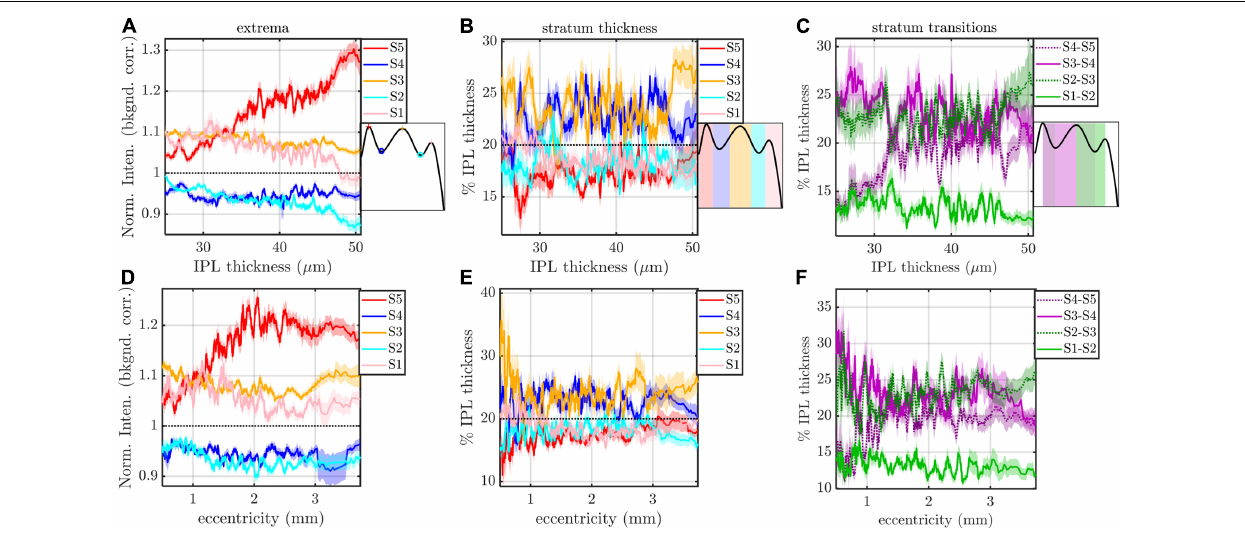
FIGURE 7 | Rolling average (mean ± std. err., window size of 21) of IPL stratification parameters (extrema, thicknesses, and transitions) versus IPL thickness (A–C) and eccentricity (D–F) . The most salient feature is an increase in the intensity of S5 with IPL thickness (A) and an increase and pleateau in the intensity of S5 with eccentricity (D) . S3 and S4 are consistently thicker, regardless of IPL thickness (B) and eccentricity (E) . In agreement with these findings, S2–S3 and S3–S4 transitions are broader than other inter-stratum transitions (C,F) . An increase in the width of the S4–S5 transition (C,F) accompanies the increased extrafoveal prominence of S5 (A,D) .